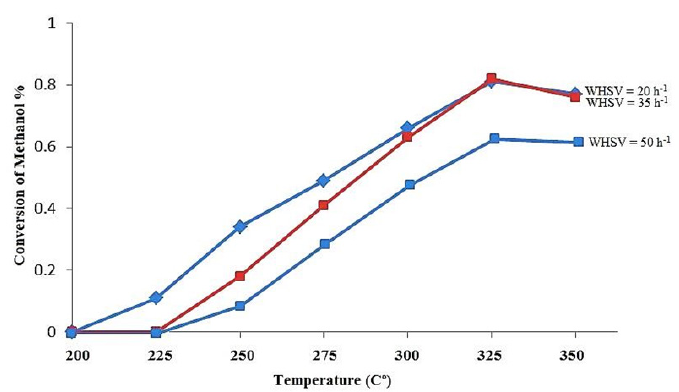
Fig. 9 . Conversion of methanol as a function of reaction temperature profile obtained over Al-A